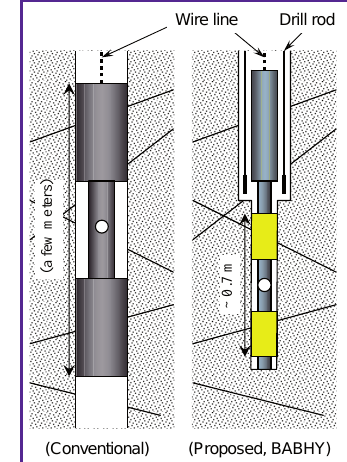
Figure 4. The compact size of the BABHY system makes it easy to find the test section free from pre-existing fractures.